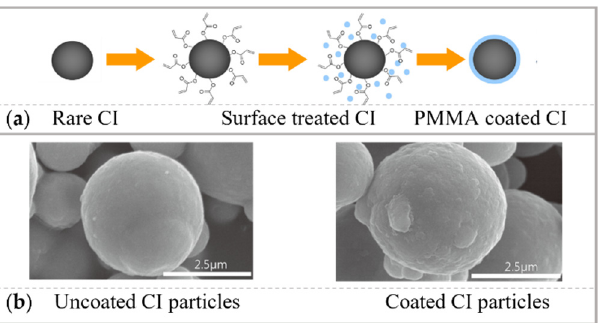
Figure 31. The magnetorheological fluid development: ( a ) The schematic diagram of the PMMA coating process. Reproduced with permission from [218]; ( b ) The SEM images of uncoated and coated CI particles. Reproduced with permission from [216].